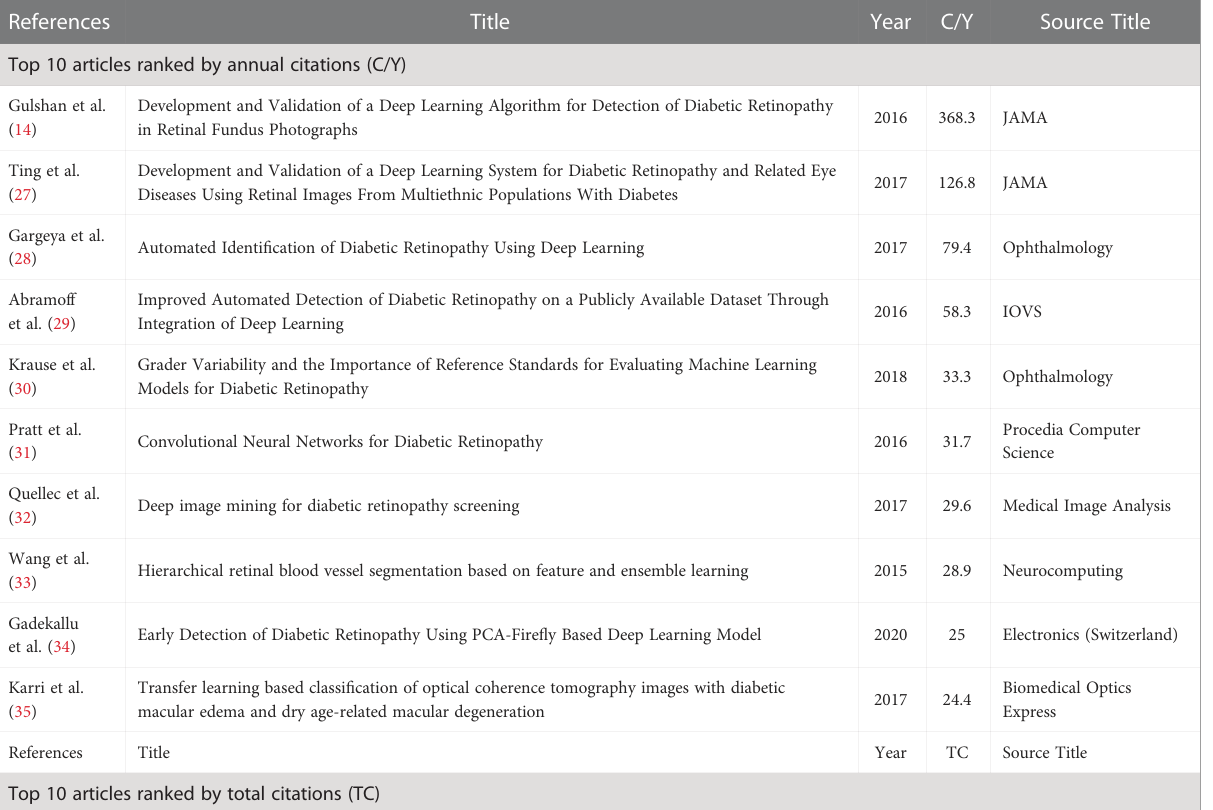
TABLE 3 Top articles ranked by annual citations and total citations.